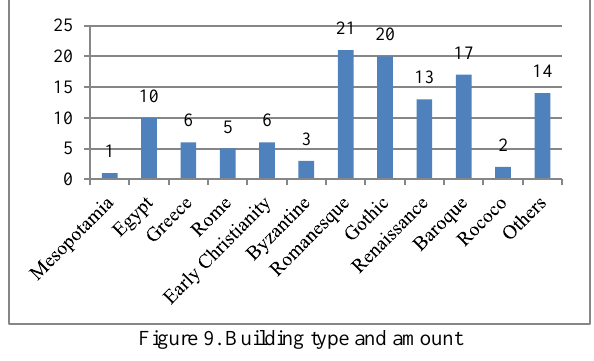
Figure 9. Building type and amount